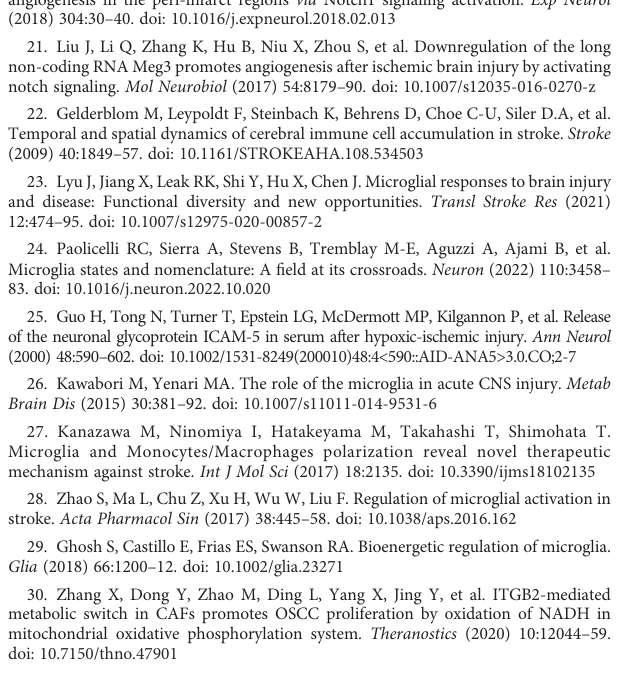
SUPPLEMENTARY FIGURE 2 The speci fi c receptor-ligand pairs between microglia and immune cells. SUPPLEMENTARY FIGURE 3 The speci fi c receptor-ligand pairs between immune cells and neuron.